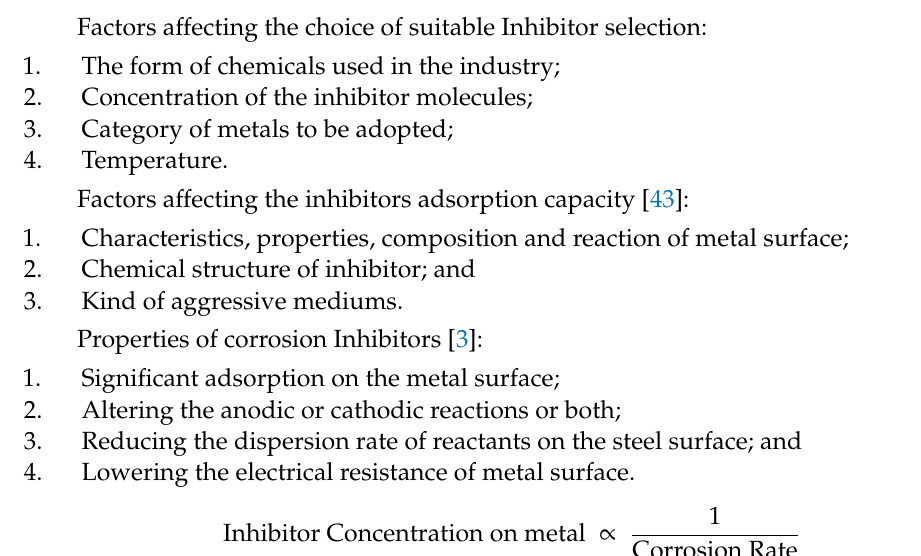
Figure 1. Inhibitors Application to Reinforced Cement Concrete.